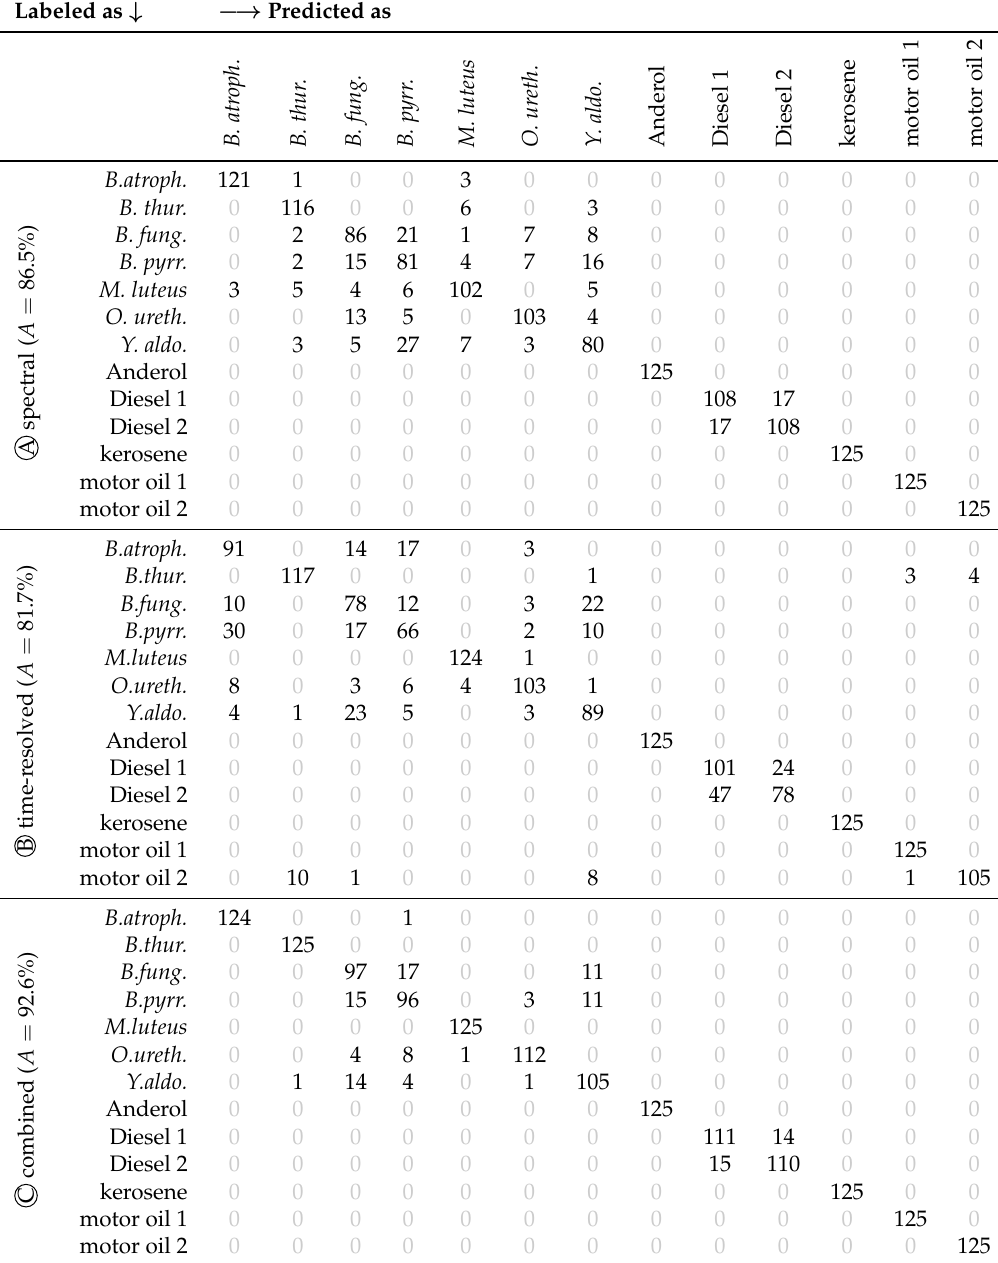
Table 1. Confusion matrices for classification of spectral, time-resolved and combined data in the upper, middle and lower part of the table, respectively. The left column indicates the accuracy of the model applied to the respective data set (see